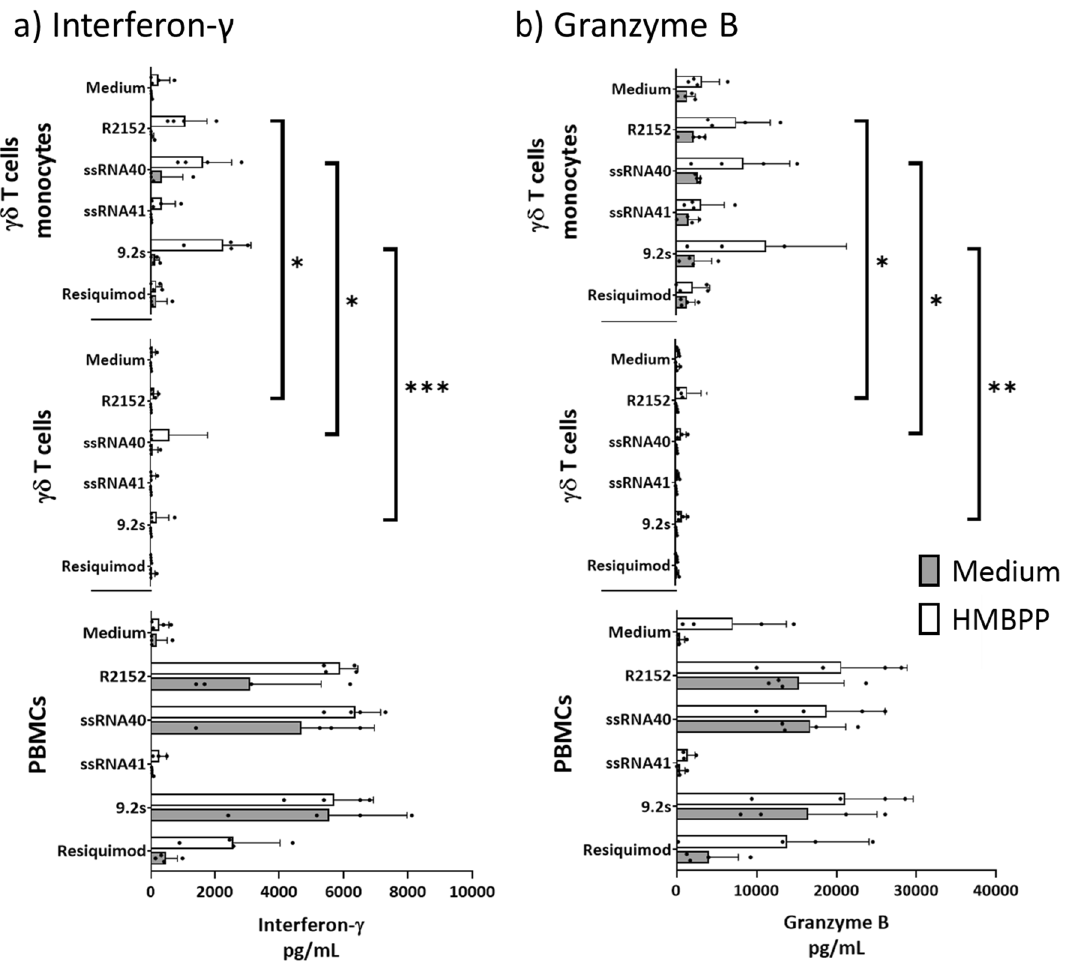
Figure 6. Co-stimulation of purified γδ T cells by TLR8 RNA ligands requires monocytes and TCR activation. 400.000 PBMC, 100.000 purified γδ T cells, and 100.000 purified γδ T cells reconstituted with 100.000 monocytes, were cultured in the absence (gray columns) or presence of HMBPP (open columns) and the absence or additional presence of TLR8 ligands. After 24 h, cell culture supernatants were collected and analyzed by ELISA for IFN-γ ( a ) and GrB ( b ). All ELISAs were performed on two independent replicates in each experiment. Mean ± SD of three to four independent experiments are shown. Statistical significance is indicated with * p < 0.05, ** p < 0.01, *** p <